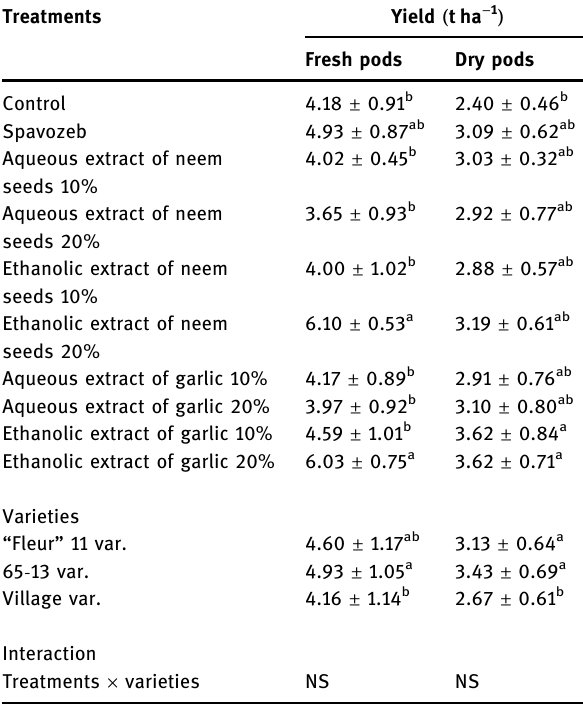
Table 7: E ff ects of phyto - extract treatments and varieties on the yield of groundnut